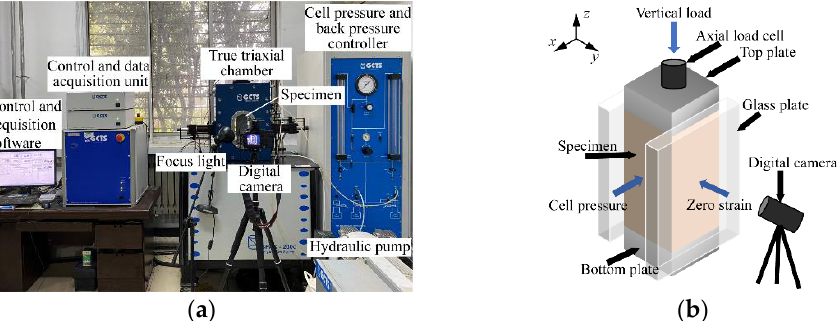
Figure 4. Testing apparatus: ( a ) photograph of the plane strain testing apparatus; ( b ) schematic of compositions of the pressure chamber and the stress state of the specimen.